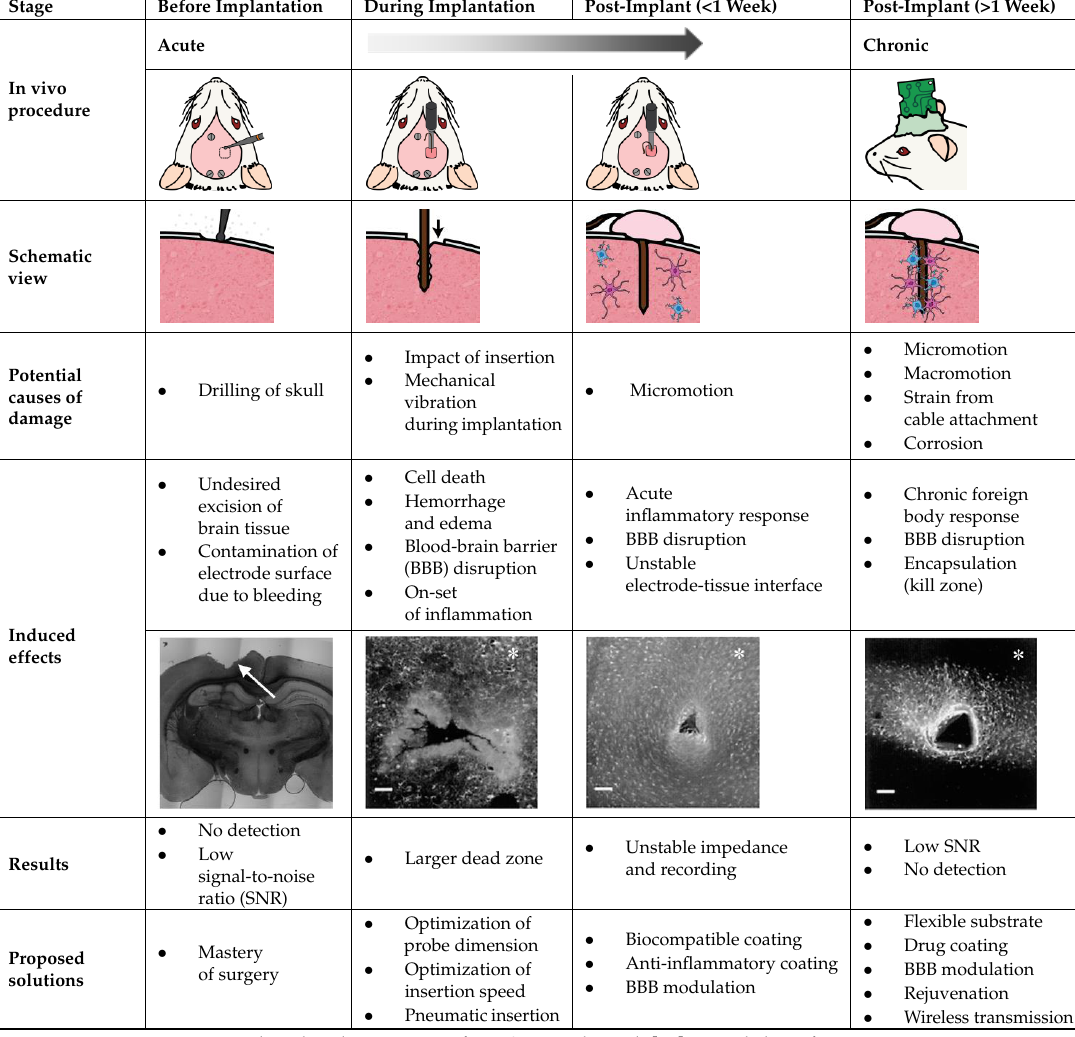
Table 1. Summary of potential causes of damages, nature of the incurred damage, and solutions to minimize the damage in chronological order of implantation *.